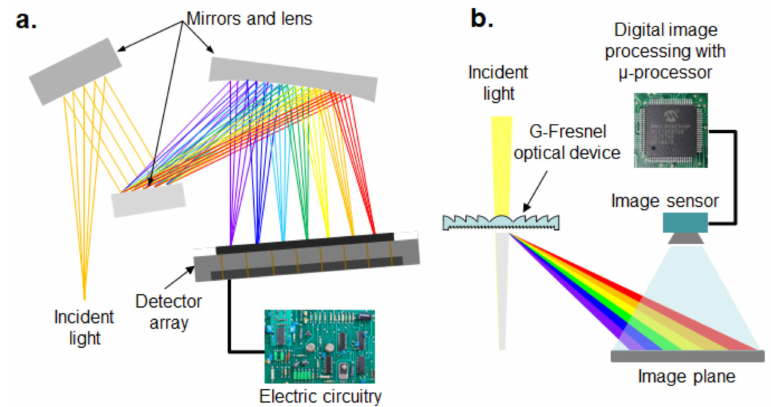
Figure 1. Comparison of the optical spectrometers: ( a ) conventional, ( b )